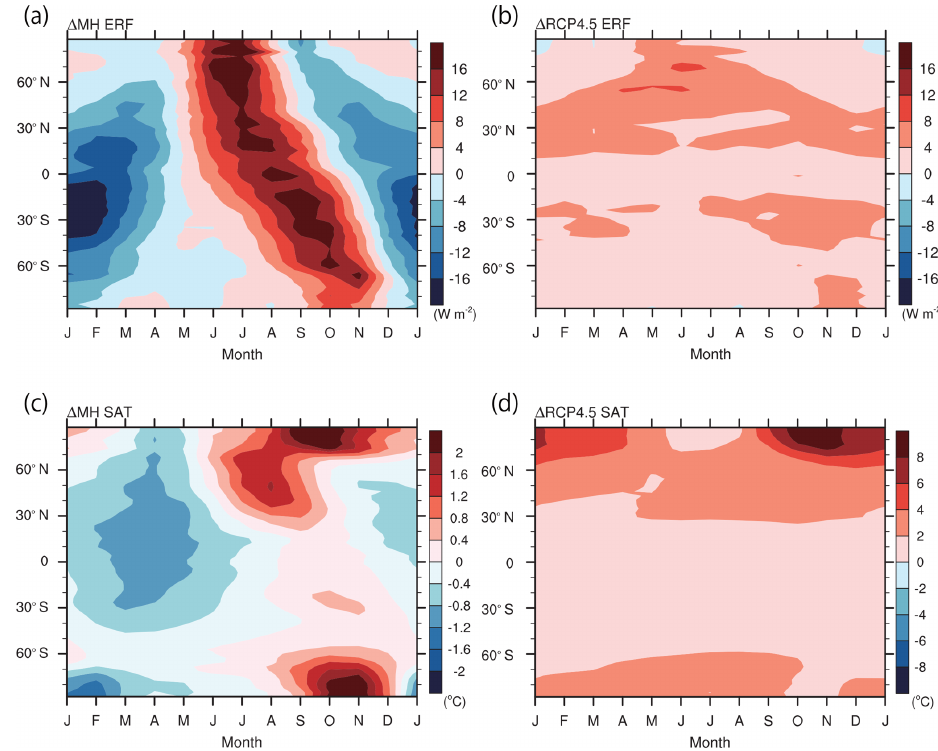
Figure 2. Seasonal progress of the zonal mean effective radiative forcing, effective radiative forcing (ERF) ( a, b ; Wm − 2 ), and surface air temperature change ( c, d , ◦ C): (a, c) (cid:49) MH and (b, d) (cid:49) RCP4.5. The ERF for (cid:49) RCP4.5 is drawn using the data from Yoshimori et al. (2018), and it is computed in the current study for (cid:49) MH. Both ERFs are constructed with a single model, MIROC4m-AGCM (Yoshimori et al., 2018). The surface air temperature changes are the means of all 10 models listed in Table